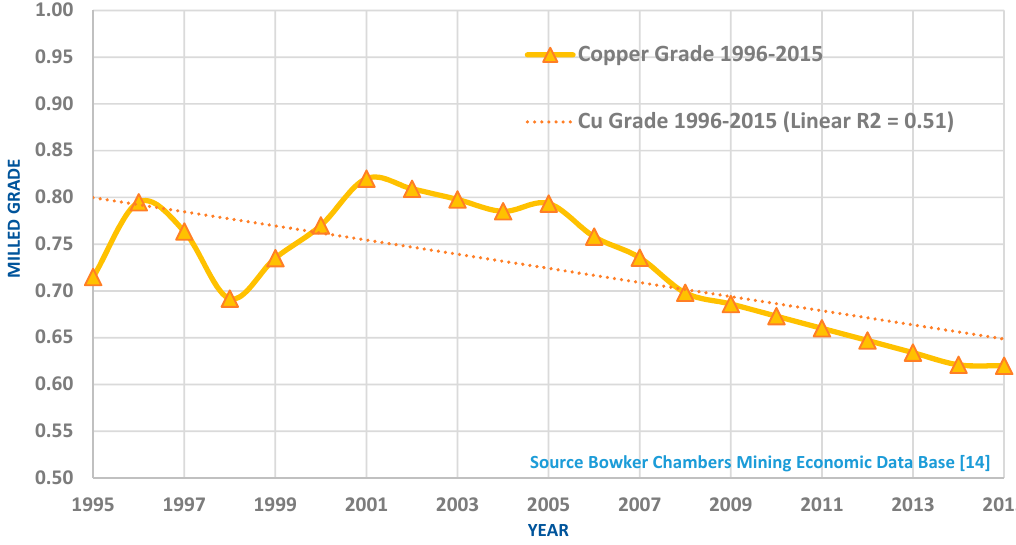
Figure 5. Global copper as-milled grade 1996–2015.